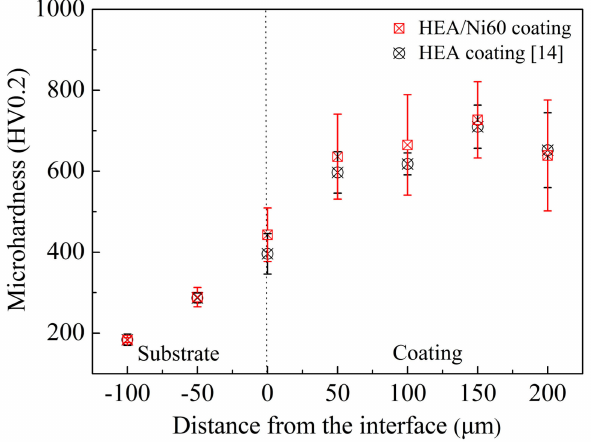
Figure 6. Microhardness of HEA/Ni60